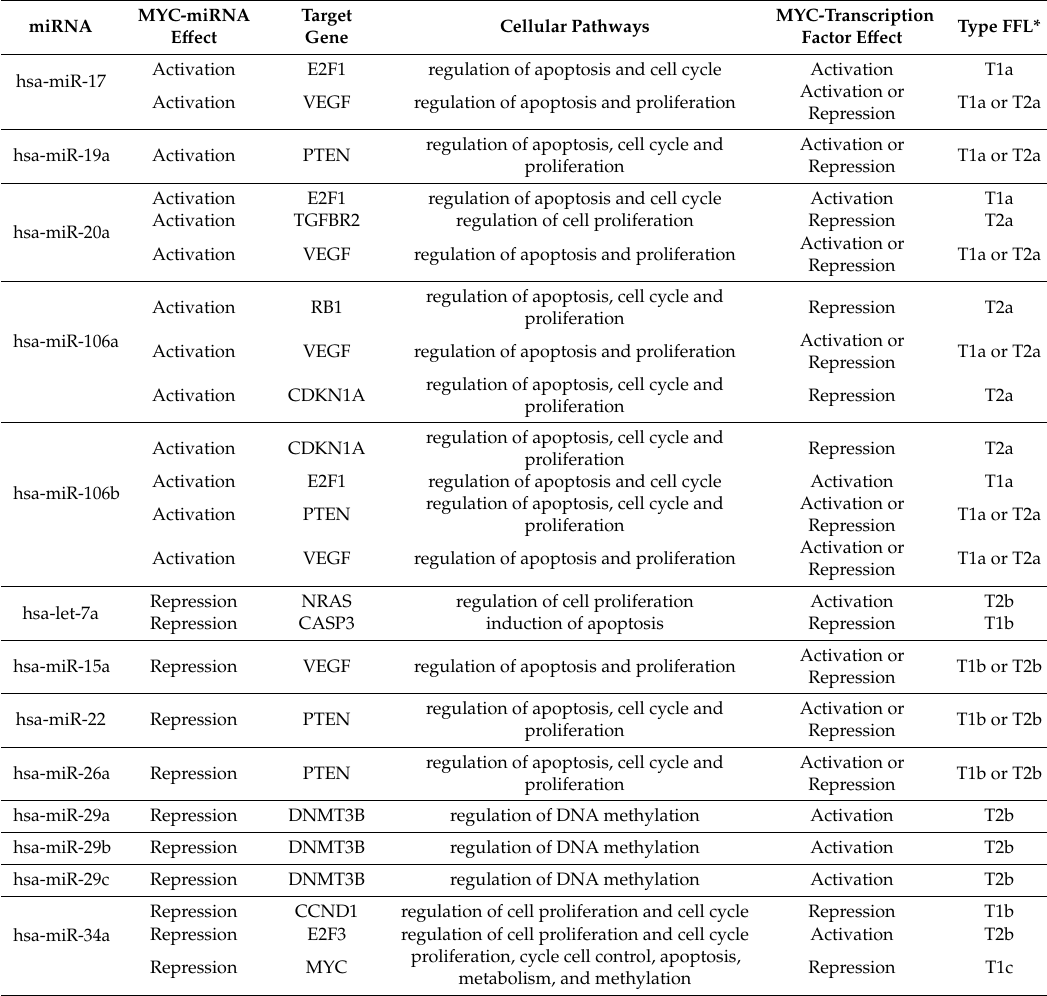
FFL*, feed forward loop type, schematic representations are described in Figure